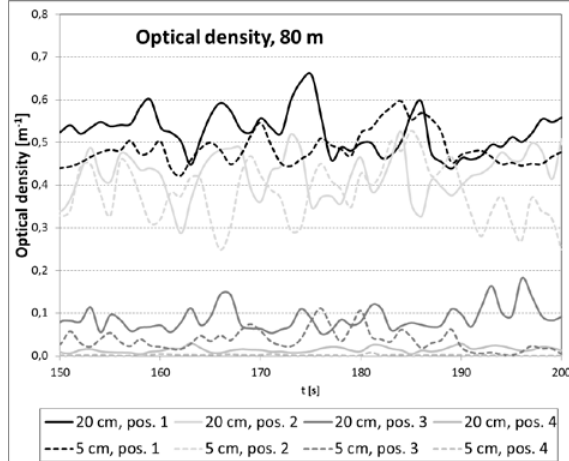
Fig. 5. Optical density of aerosol for 5 and 20 cm mesh resolution measured by quadruple of detectors at 80 m from the fire source after steady-state conditions are formed.